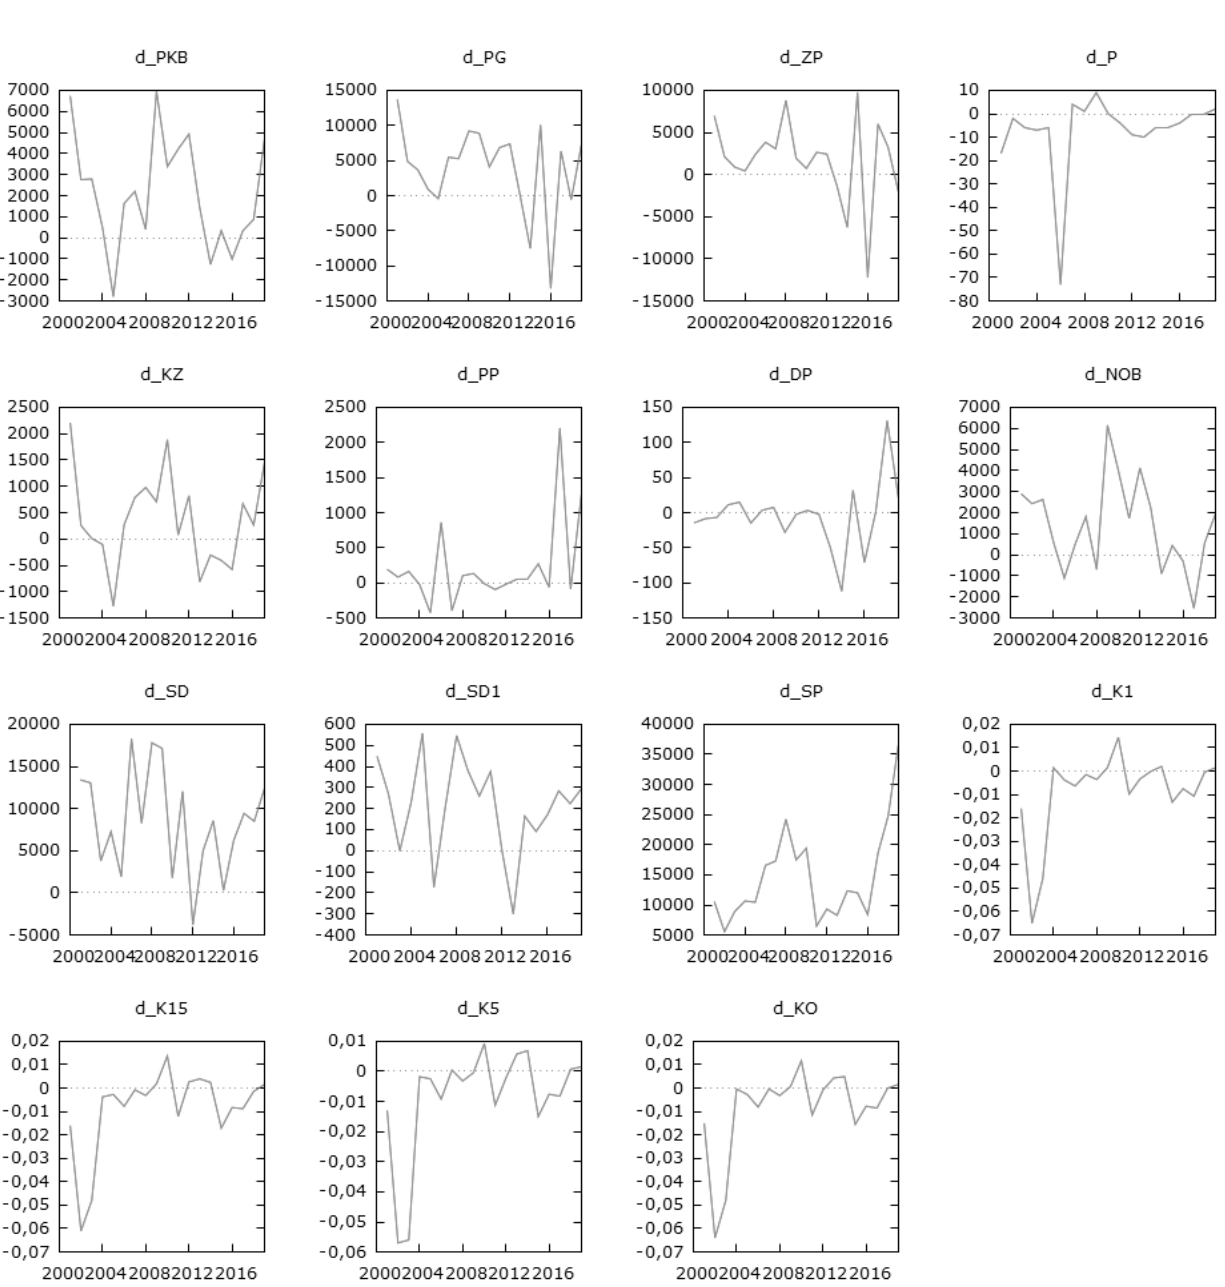
Figure A2. Stationary variables from groups C, D and E. Source: Authors’ study.